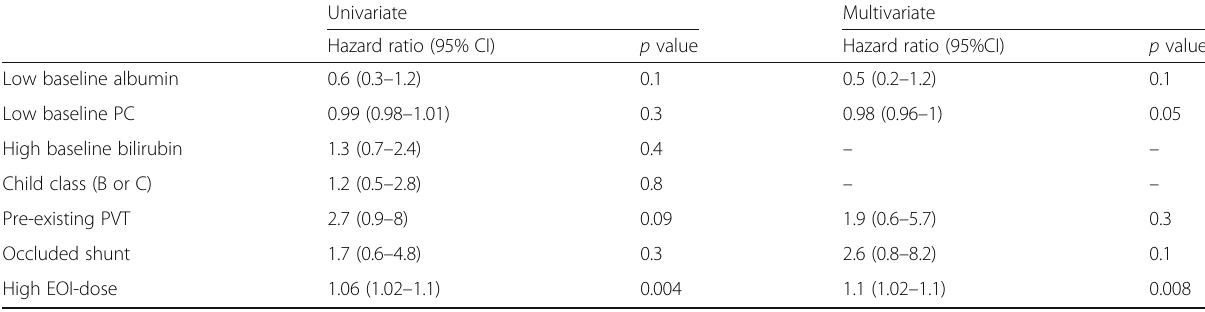
Table 2 Univariate and multivariate analysis of prognostic factors for ascites exacerbation after